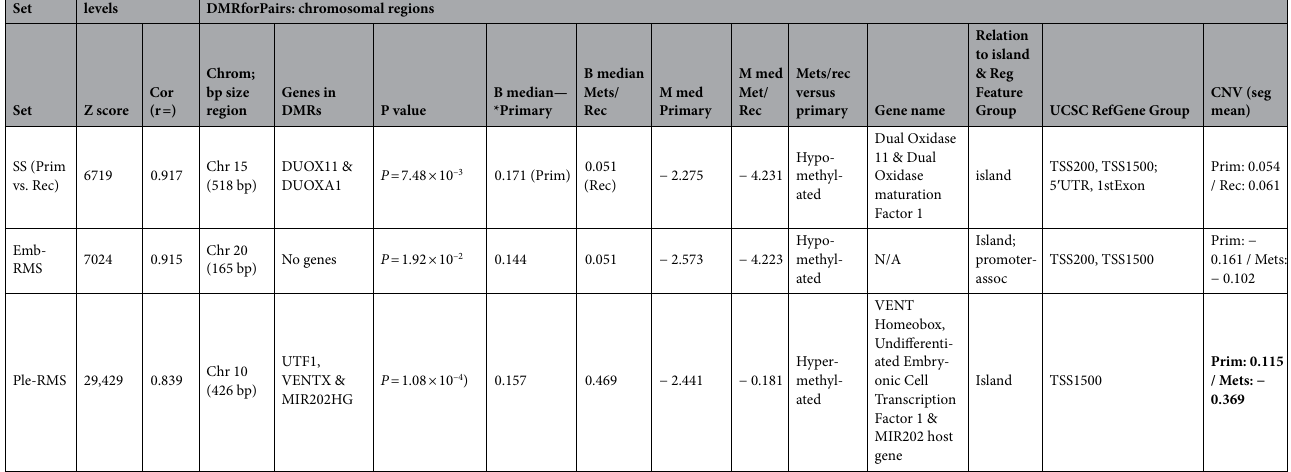
Table 3. Summary of methylation levels, DMR of Pairs and Variance Analysis in all paired comparisons analysed. P: Primary; M: Metastasis; LMS: Leiomyosarcoma; MFS: Myxofibrosarcoma; SS: Synovial sarcoma; RMS: Rhabdomyosarcoma; Emb: Embryonal; Ple: Pleomorphic; Cor: Correlation; bp: base pair; Chr: chromosome. DMRs: Differentially methylated regions; Mets: Metastasis; Rec: Recurrence; Relation to Island: The location of the CpG relative to the CpG island. Reg (Regulatory) Feature Group: Description of the regulatory feature as provided by the Methylation Consortium. Shore = 0–2 kb from island; Shelf = 2–4 kb from island; N = upstream (5 ′ ) of CpG island; S = downstream (3 ′ ) of CpG island. UCSC Ref Gene Group: Gene region feature category describing the CpG position, from UCSC. When more than one feature is listed indicates different target gene transcripts. 5 ′ UTR = Within the 5 ′ untranslated region, between the TSS and the ATG start site; Body = Between the ATG and stop codon; irrespective of the presence of introns, exons, TSS, or promoters; TSS200 = 0–200 bases upstream of the transcriptional start site (TSS); TSS1500 = 200–1500 bases upstream of the TSS. 3 ′ UTR = Between the stop codon and poly A signal (As per descriptions of the Infinium MethylationEPIC Array manifest file column